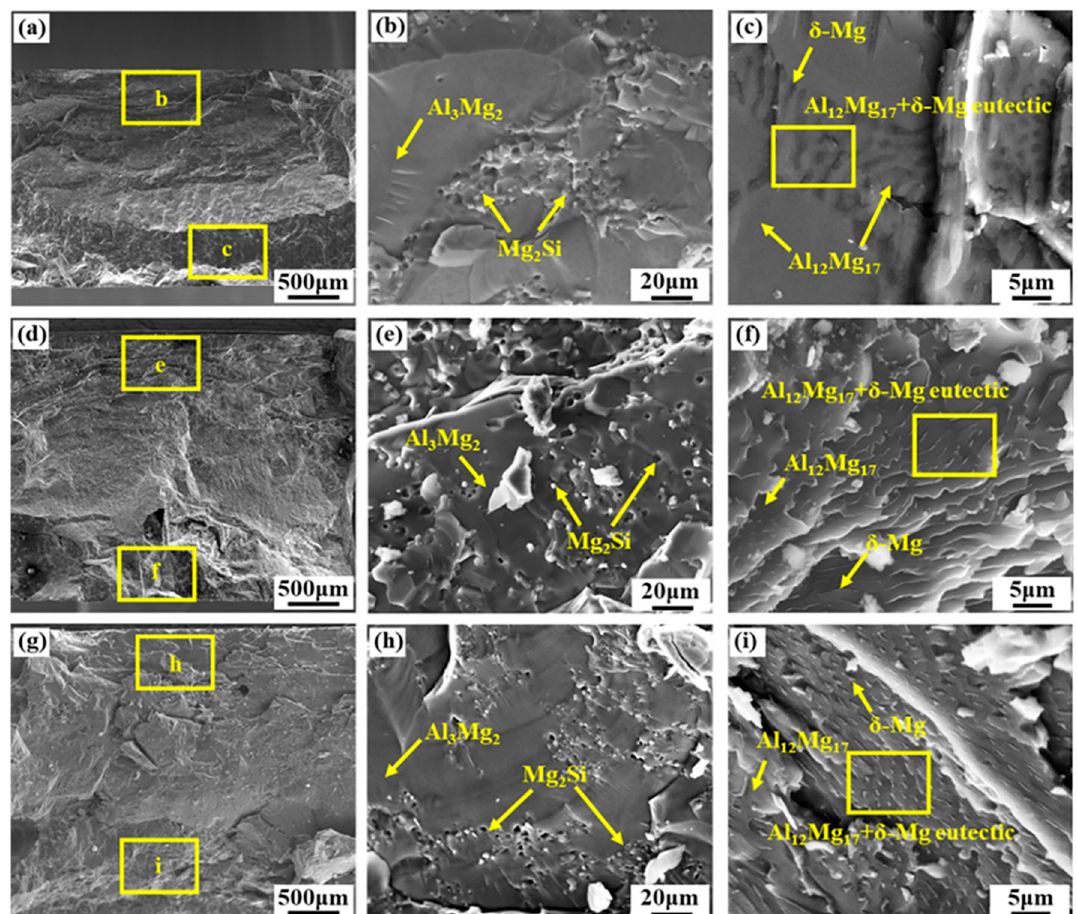
Figure 10. SEM morphologies of the fracture surfaces of the Mg–Al bimetals at the Mg substrate side: ( a ) macroscopic morphology of the fracture surface of the Mg–Al bimetal without vibration; ( b , c ) enlarged images of region b and c in ( a ), respectively; ( d ) macroscopic morphology of the fracture surface of the Mg–Al bimetal with the vibration acceleration of 0.3 g; ( e , f ) enlarged images of region e and f in ( d ), respectively; ( g ) macroscopic morphology of the fracture surface of the Mg–Al bimetal with the vibration acceleration of 0.9 g; and ( h , i ) enlarged images of region h and i in ( g ), respectively.